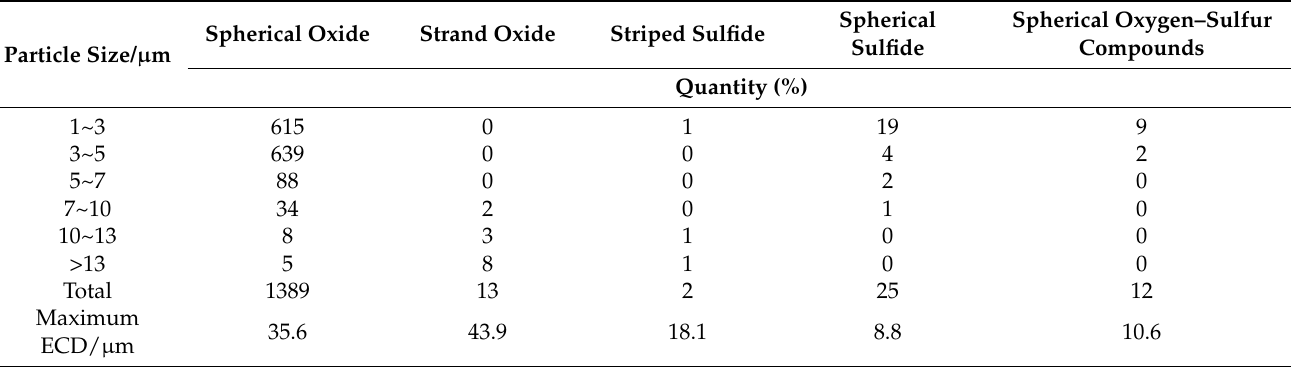
Table 8. Results of the particle size distribution of inclusions in 100 mm 2 of Sample